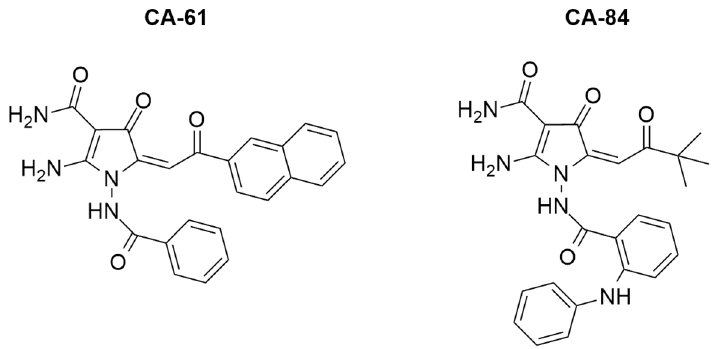
4-oxo-4,5-dihydro-1-H-pyrrole-3-carboxamide—CA-61 and 2-amino-5-(3,3-dimethyl-2-oxobutyli-